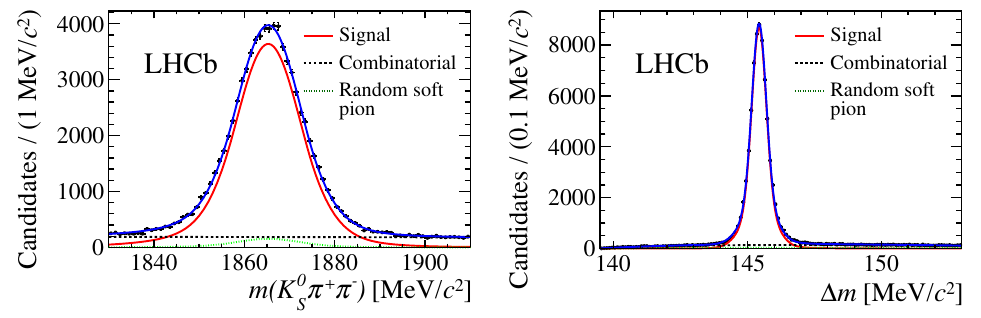
( ) D 0 ( ! K 0 (cid:25) + (cid:25) (cid:0) ) (cid:25) (cid:6) S